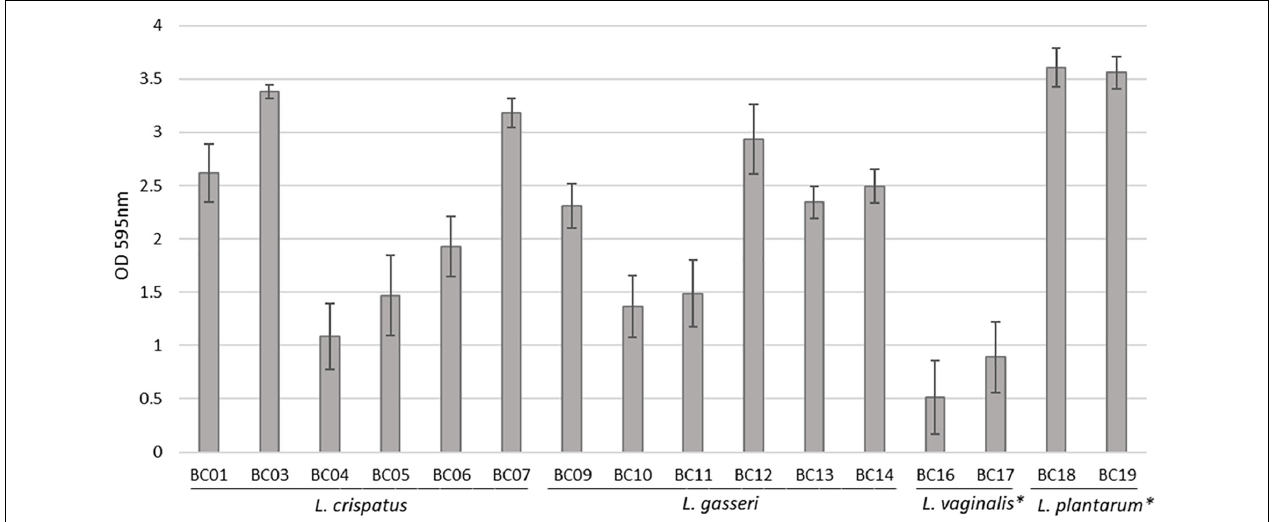
FIGURE 1 | Biofilm formation by Lactobacillus strains, evaluated by crystal violet staining (average ± st. dev.). ∗ p < 0.05 selected species vs. other Lactobacillus species.